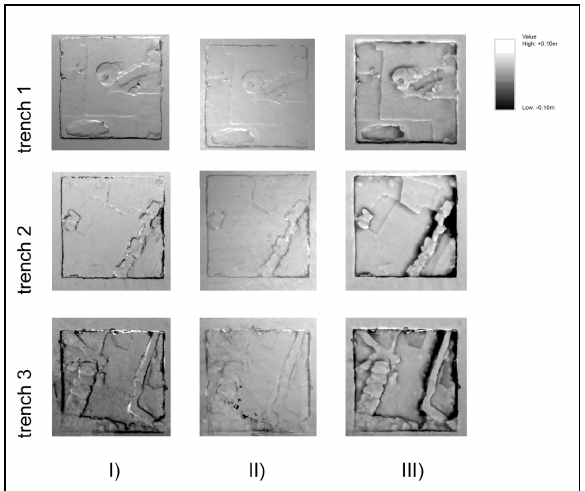
Figure 11. Monochromatic rendering of the “difference image” resulting from the 3D model comparison (4/7/2019) between (I) laser scanner and DSLR Canon EOS 1200D, (II) laser scanner and aerial Sequoia RGB Parrot and (III) laser scanner and aerial Sequoia MultiSpectral of the 3 archaeological trenches.